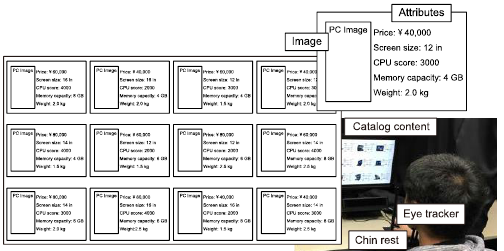
Figure 5. Experimental environment and displayed content of a catalog. Each item region consisted of a picture and descriptions of the PC attributes in text format. (Descriptions in this figure are translations from the original language,